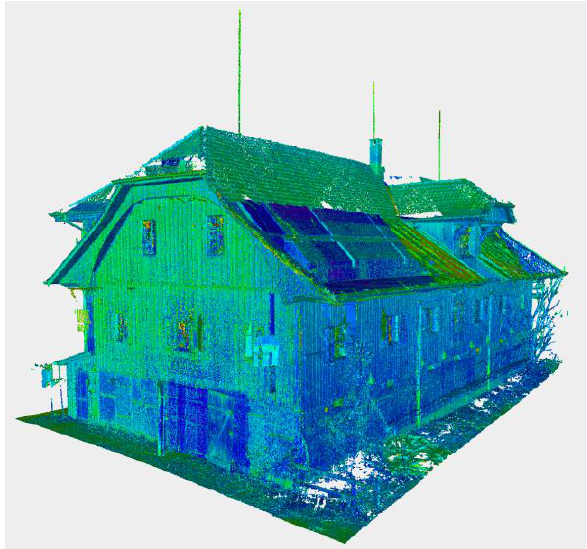
Figure 6 . Point cloud of scanned Salzmagazin building